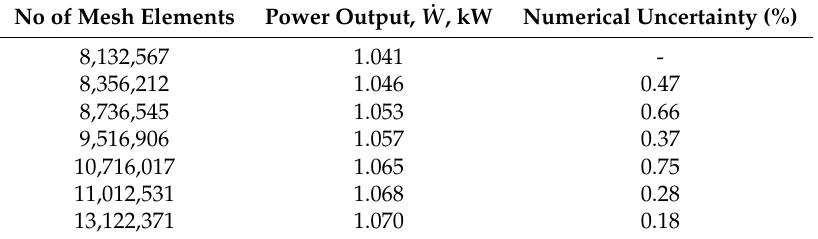
Table 2. Grid convergence results of the double-nozzle turbine at maximum efficiency.